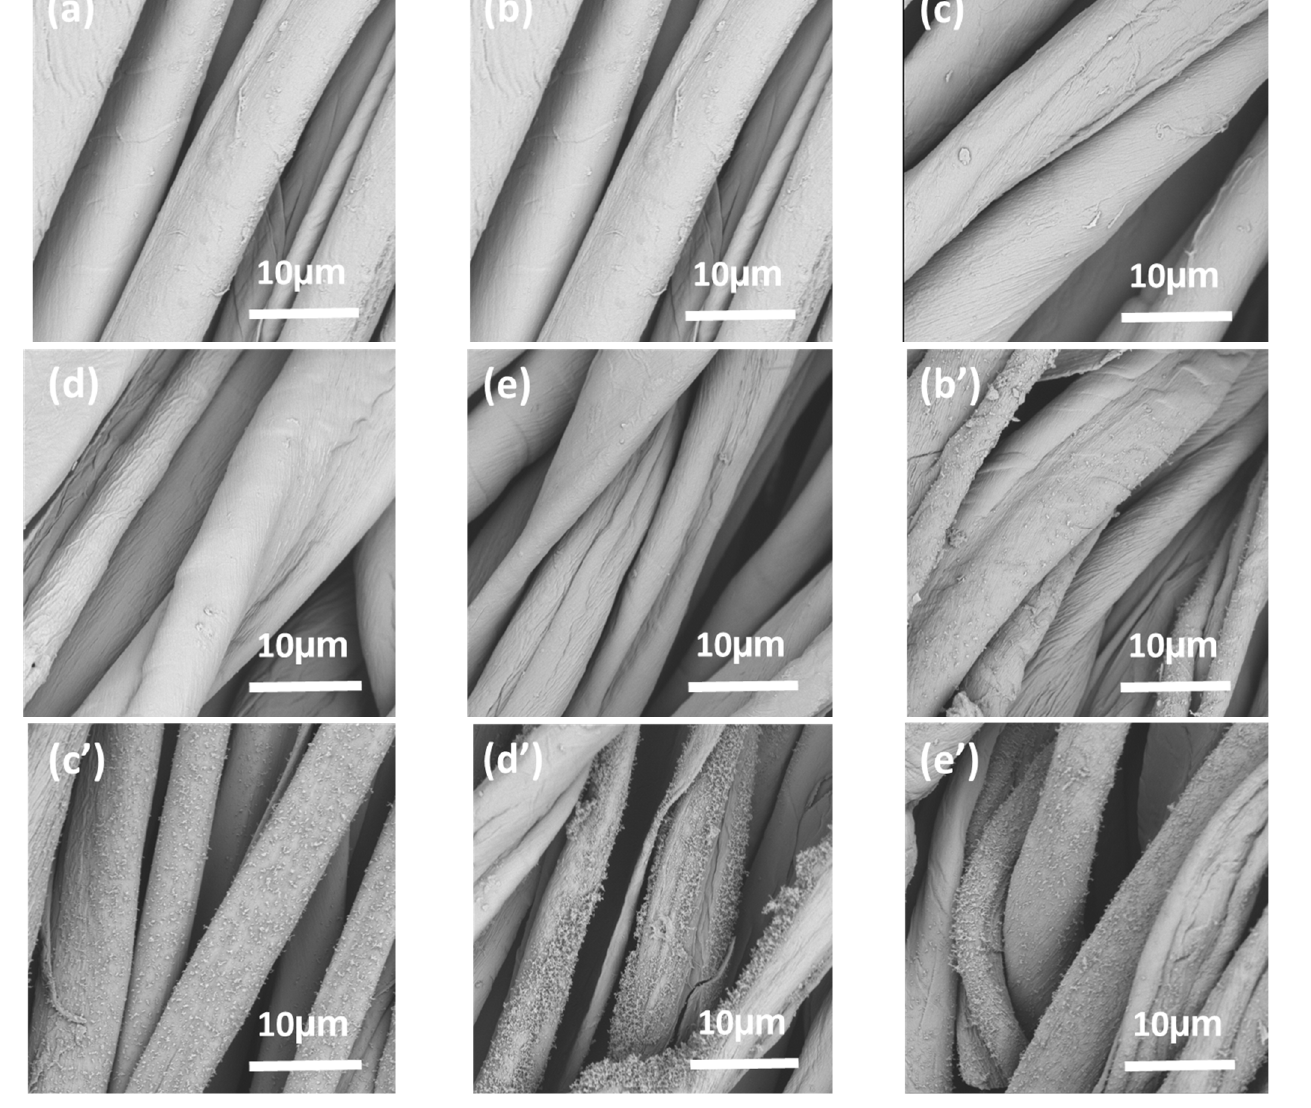
Figure 9. SEM micrographs of the control sample ( a ), BDA-30 ( b ), BDA-60 ( c ), BDA-90 ( d ), BDA-120 ( e ) (3 curing times, 50 LCs), and after burning ( b’ – e’ ), respectively. Scale bars are 10.0 µ m (×5000).